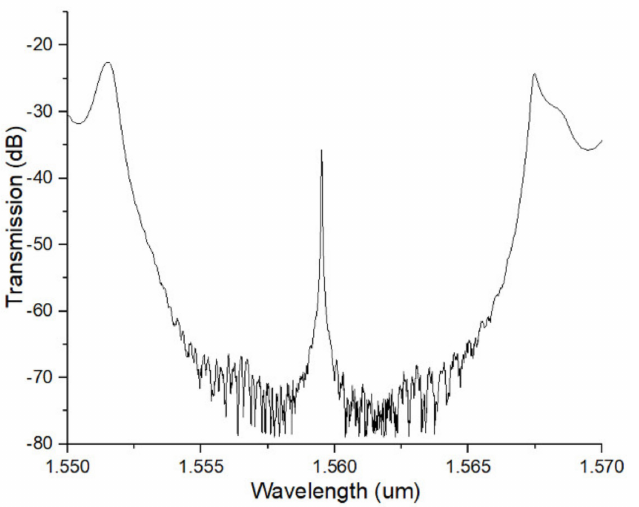
Figure 11. The transmission result from the measurement of the 1D PhC with the